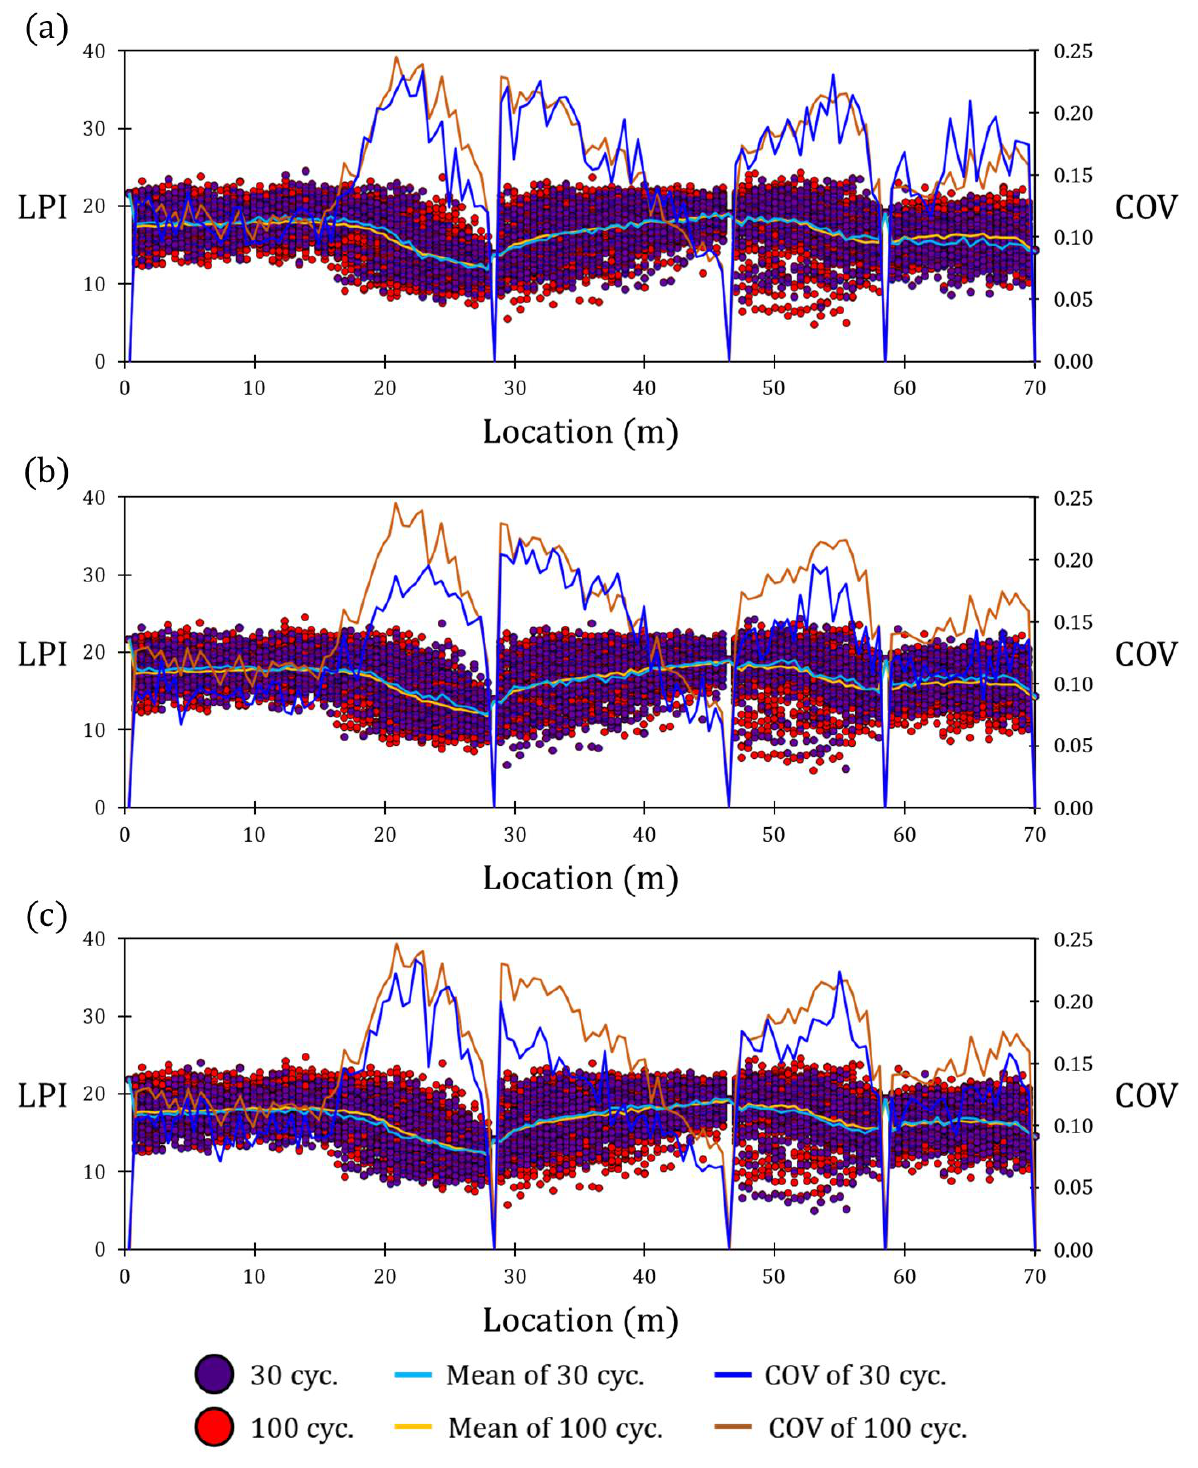
Figure 13. Comparison of 30 and 100 cycles of liquefaction-potential evaluations of the CMC random-field-parameter model through the JRA method. ( a ) Realization 1. ( b ) Realization 2. ( c ) Realization 3.